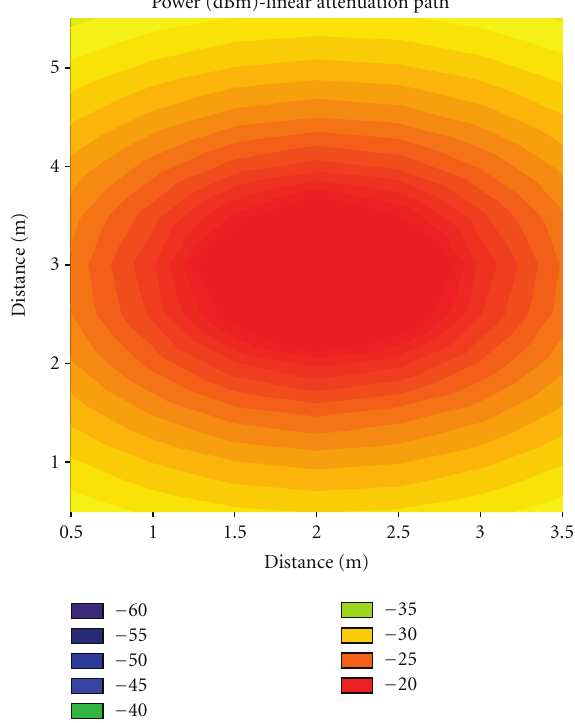
Figure 4: Spatial distribution of received power (dBm) for a height of 1.05 m in the indoor scenario of Figure 2(a) with Linear Attenuation Path